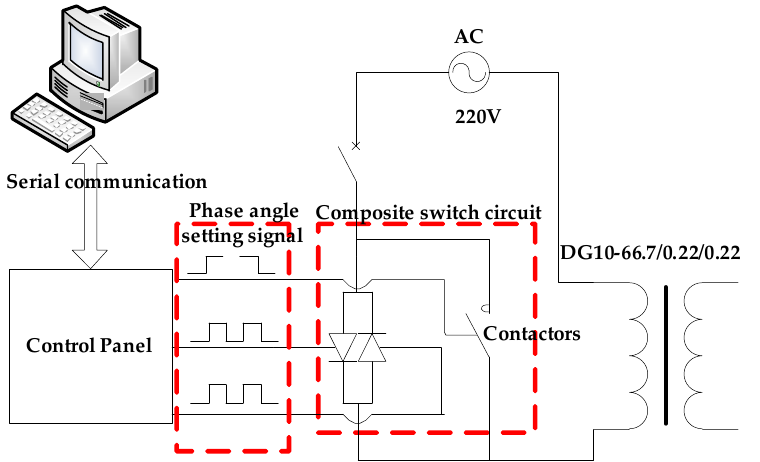
Figure 19. Schematic diagram of the phase-controlled switch composed of thyristors.